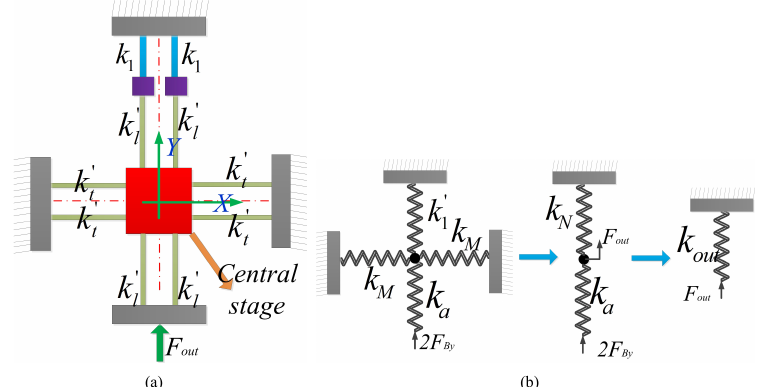
Figure 8. The stiffness of output mechanism: (a) the diagram of the output mechanism; (b) the output stiffness transformation diagram.